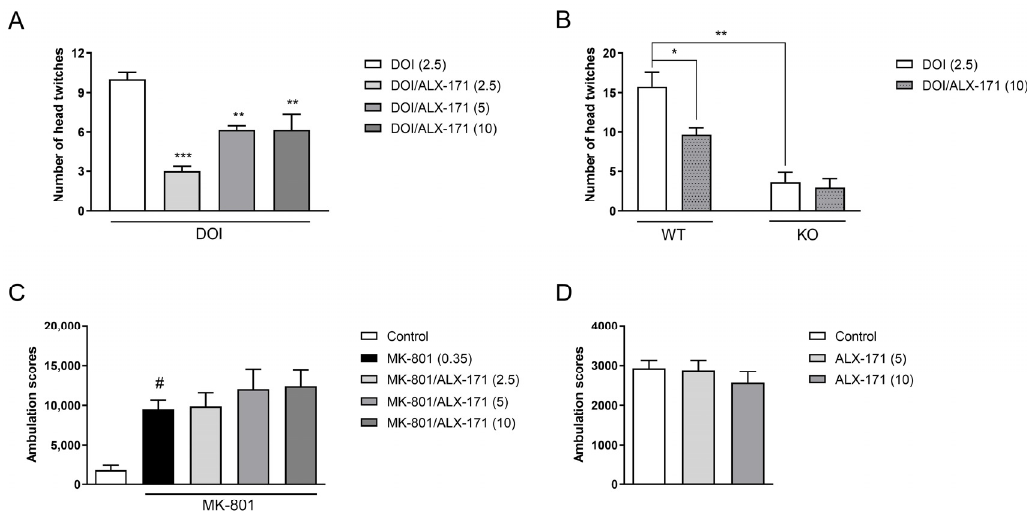
Figure 8. The effect of ALX-171 on the DOI-induced HTR test ( A , B ) and MK-801-induced hyperac- tivity ( C ). The effect of ALX-171 on the locomotor activity of naïve mice ( D ). Doses are indicated in parentheses as mg/kg. The data are presented as means ± SEM. ( A ) One-way ANOVA: F (3.20) = 15.46, p < 0.0001; ** p < 0.01; *** p < 0.001 vs. DOI-treated group. ( B ) Two-way ANOVA: KO (F (1.11) = 51.33, p < 0.0001); ALX-171 administration (F (1.11) = 6.432, p < 0.03); * p < 0.05, ** p < 0.01 vs. DOI-treated WT mice. ( C ) # p < 0.0001 vs. control group.